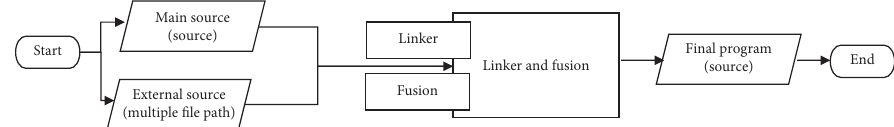
Figure 3: Multifiles linker in static